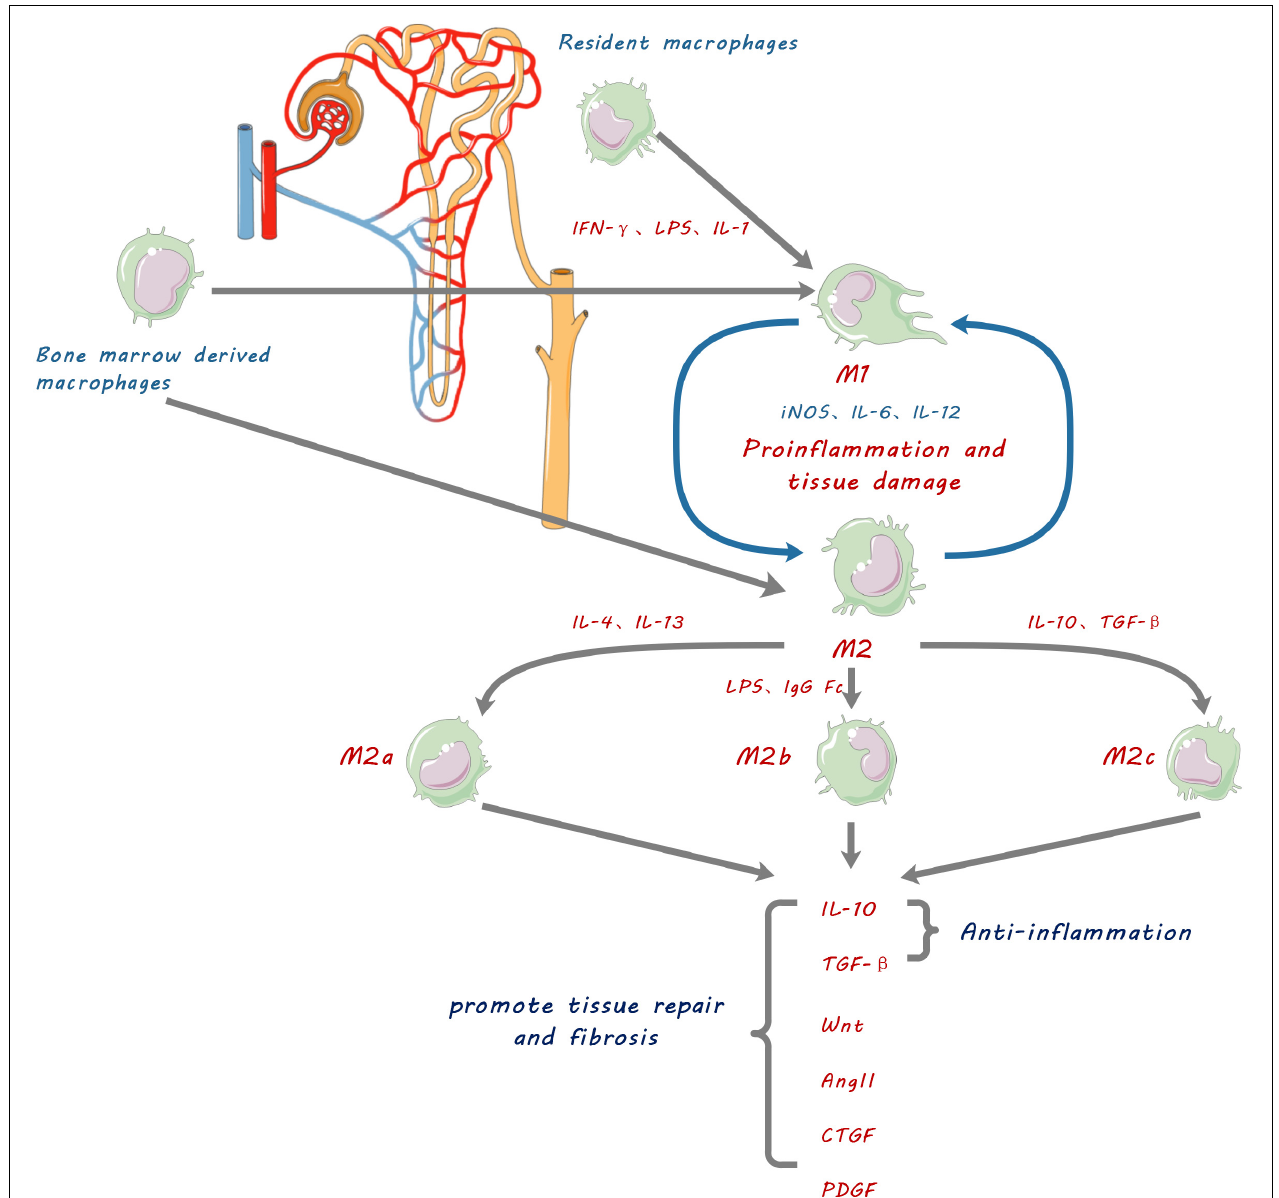
FIGURE 1 | Schematic diagram showing macrophage contribution to kidney fibrosis. Kidney resident macrophages and infiltrating bone marrow-derived macrophages are stimulated by inflammatory factors such as IFN- γ , lipopolysaccharide (LPS), and IL-1, to be polarized into pro-inflammatory M1 macrophages which promote inflammation and tissue damage by releasing IL-6, 12 and inducible nitric oxide synthase (iNOS). They can also be polarized into three functionally different phenotypes of anti-inflammatory and reparative M2 macrophages by anti-inflammatory cytokines IL-4, IL-10, IL-13, and TGF- β . M2 macrophages